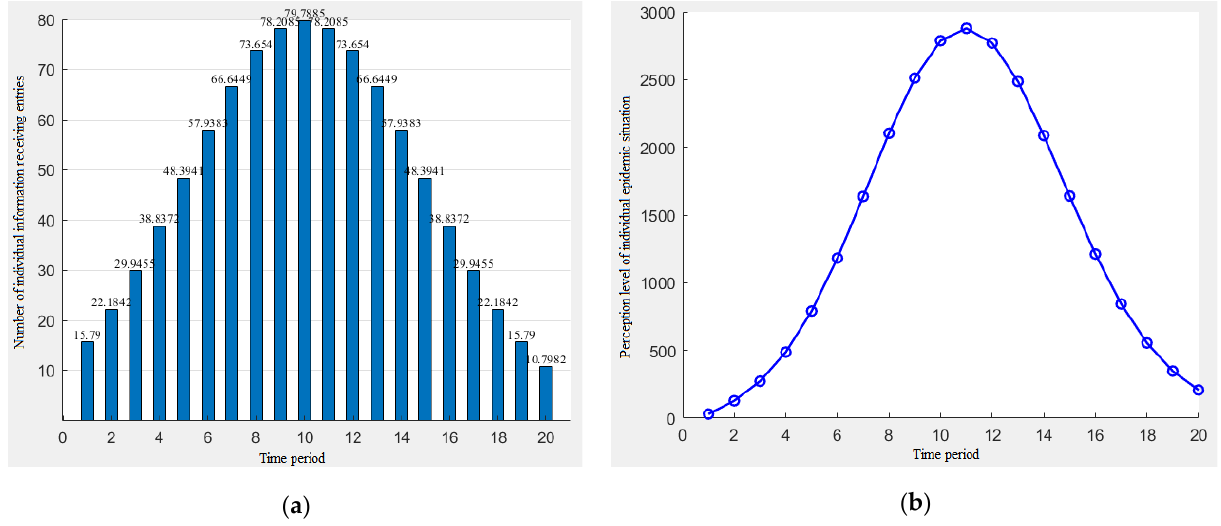
Figure 5. Individual information acceptance increases first and then decreases ( a ) and the change of the individual perception level ( b ). the individual perception level ( b ).